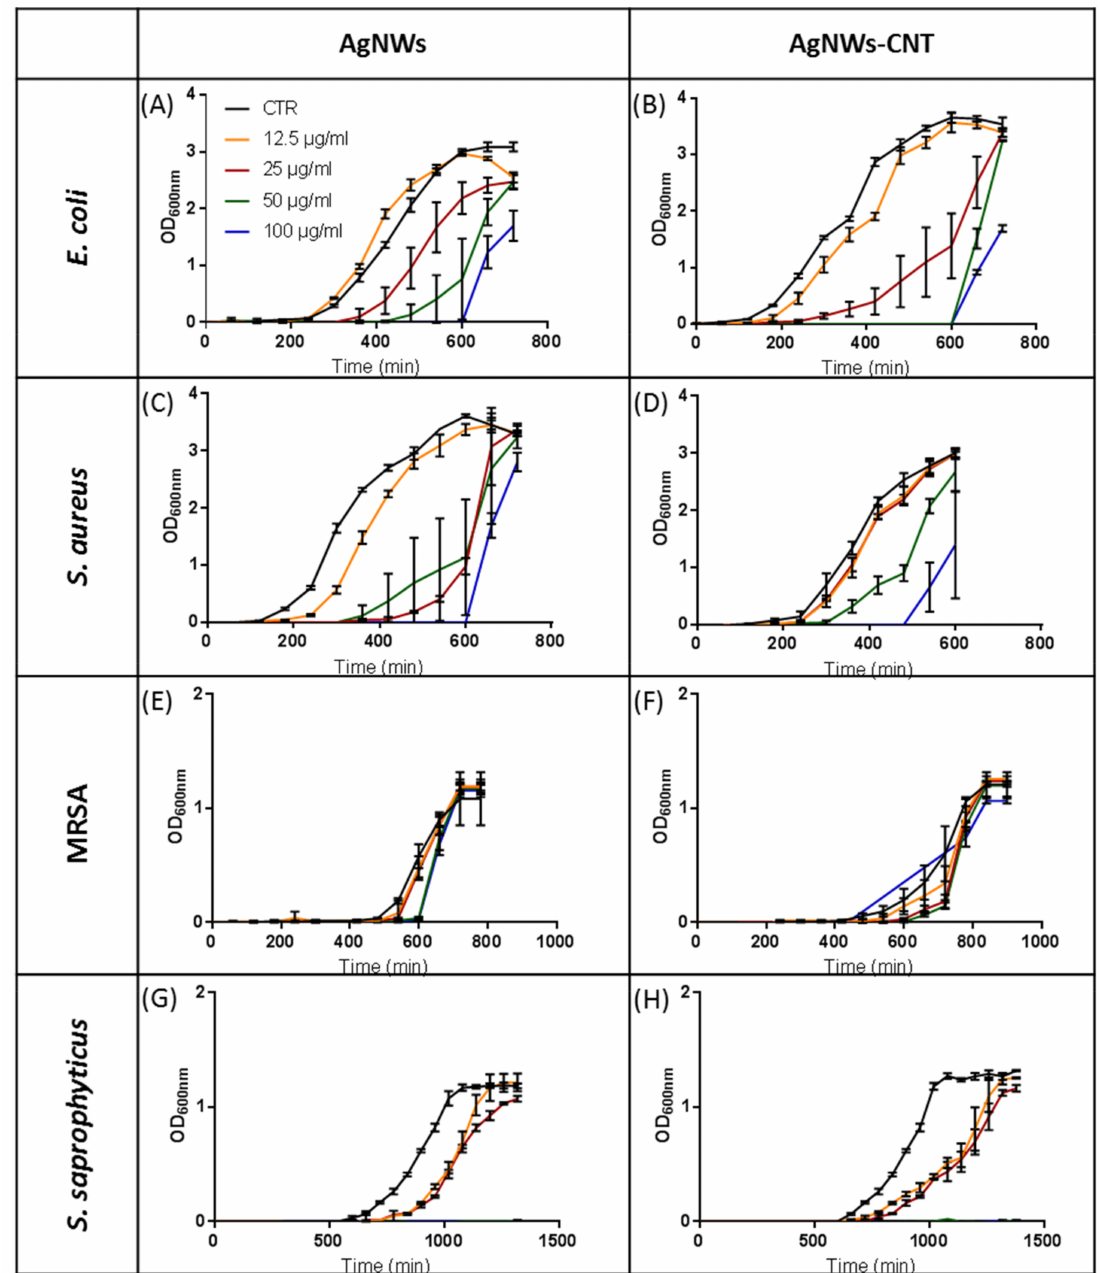
Figure 3. Growth curves of bacteria with di ff erent concentrations of AgNWs ( A , C , E , G ) and AgNWs-CNT ( B , D , F , H ). Results are reported as the mean ± SD ( n =